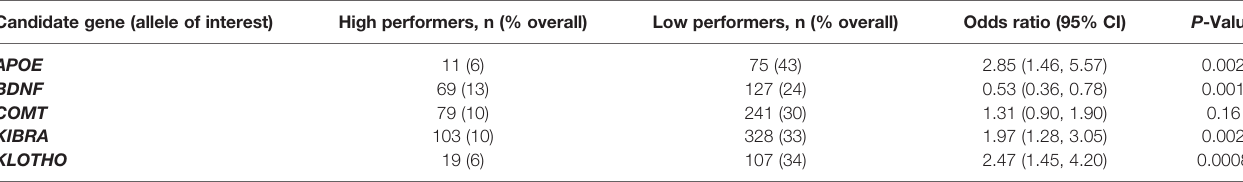
Candidate geneallelesofinterest(left column)carrierstatus withassociated prevalence amonghigh (>1SDfrommean) andlowperformers (<1SDfrommean)acrossanyneurocognitive domain at all timepoints of testing. Odds ratio with 95% con fi dence interval indicates increased (APOE, KIBRA, KLOTHO) versus decreased risk (BDNF) of being among low performers. Last column contains statistically signi fi cant P-value (P <